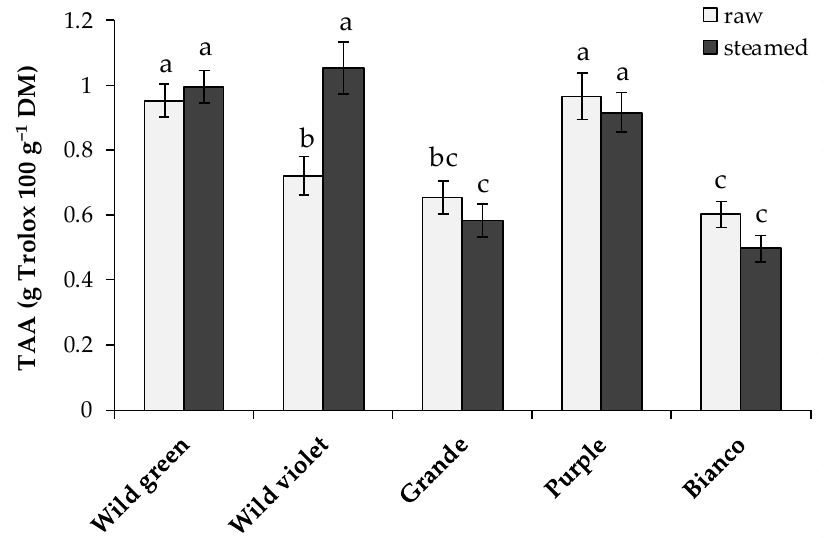
Figure 3. Total antioxidant activity (TAA) in raw and steamed asparagus ( p ≤ 0.001). The same letters indicate that the mean values are not significantly different ( p = 0.05). Vertical bars indicate the standard deviation. Grande = ‘Grande’; Purple = ‘Purple Passion’; Bianco = ‘Bianco di Bassano del Grappa’. Table 1. Effects of steaming on phenolic composition in different genotypes of asparagus. SD = standard deviation.